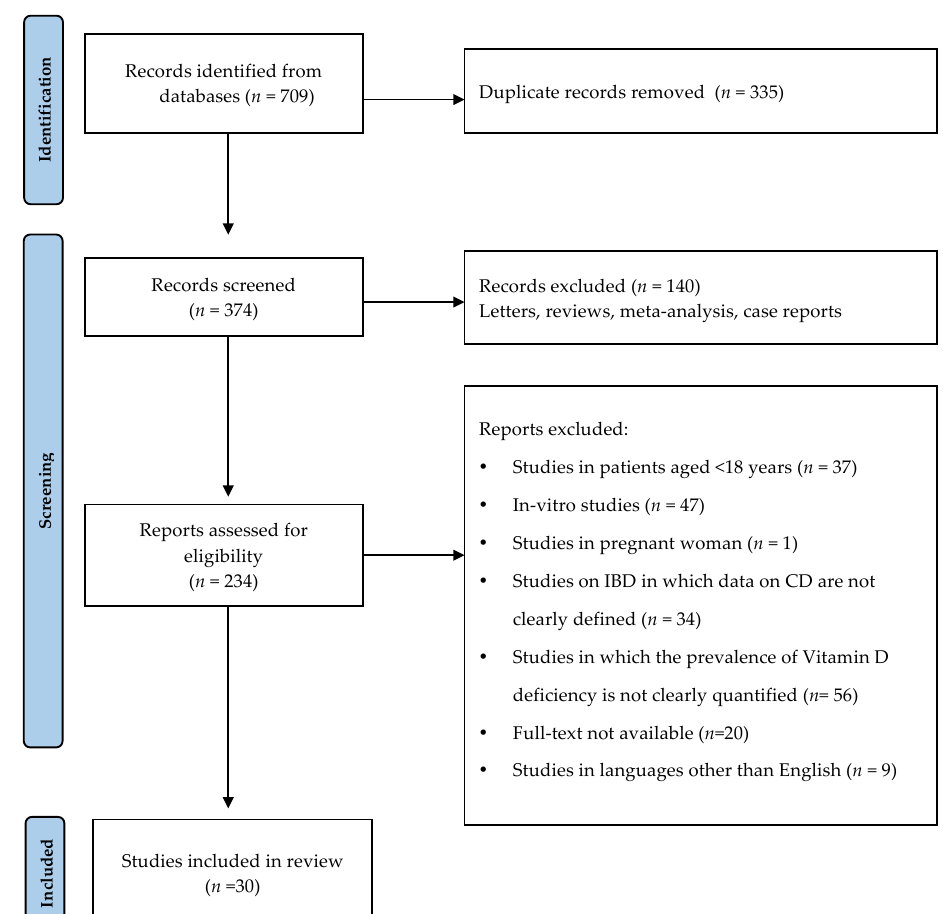
Figure 3. Flow diagram of the study selection process (adapted from PRISMA)